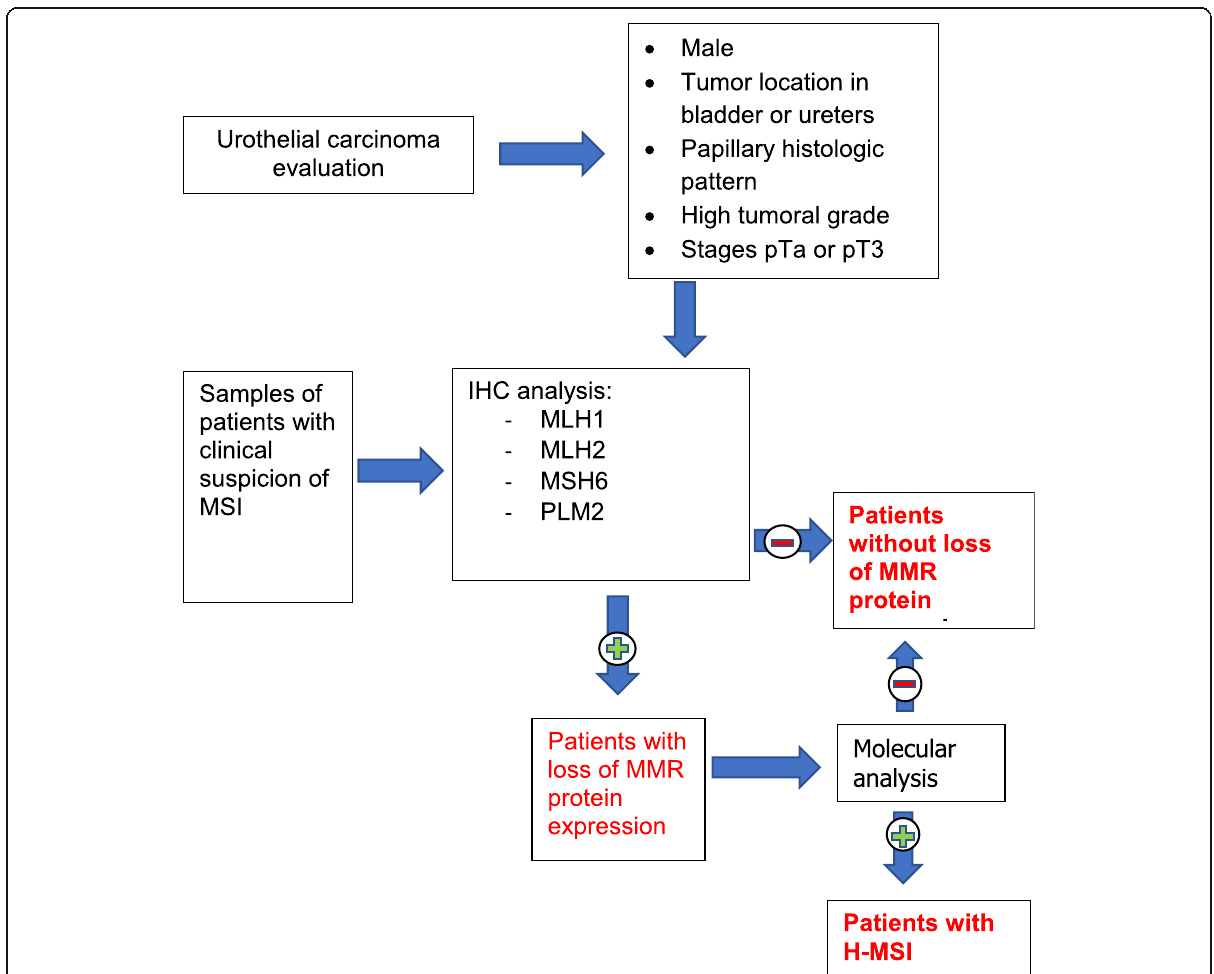
Fig. 2 Screening protocol for the identification of patients with urothelial carcinomas with loss of MMR protein